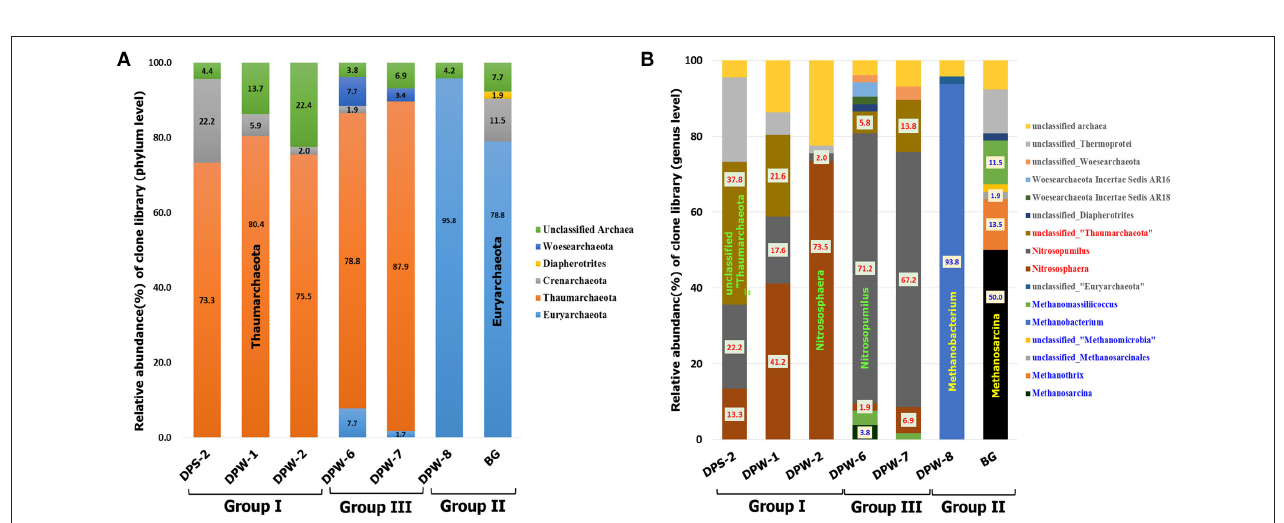
FIGURE 5 | Comparison of the dominant archaeal taxa at the phylum (A) and genus (B) level. All microbes at the phylum (A) and genus (B) level are represented, including ammonia oxidizing archaea (red) and methane producing or methane oxidizing archaea (blue).